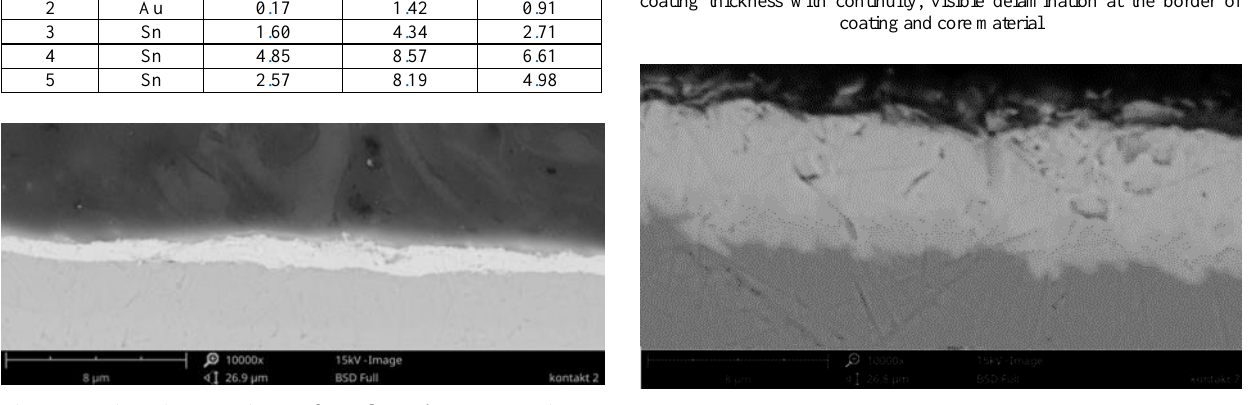
Fig. 6. Scanning microscope image of sample number 4 – a continuous layer with even coating thickness, visible impurities in the coating